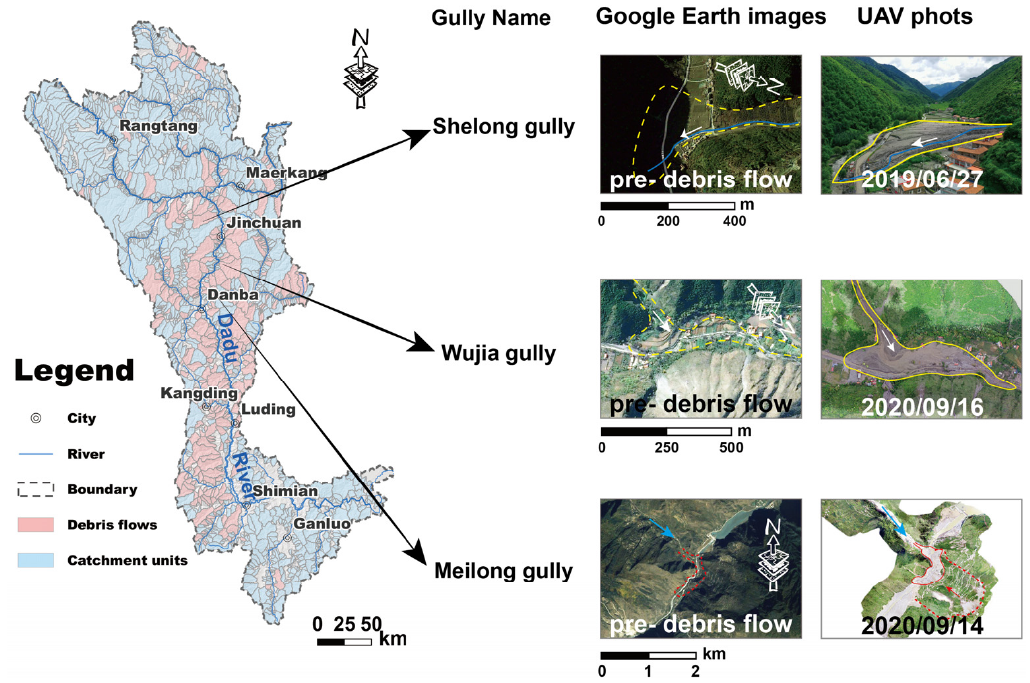
Figure 3. Catchment units in the Dadu River basin.